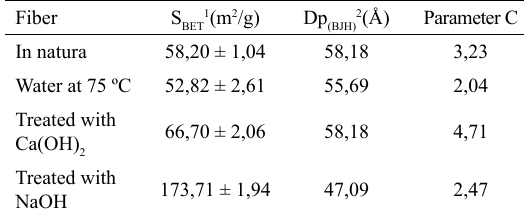
Table 2. Properties of fibers after different